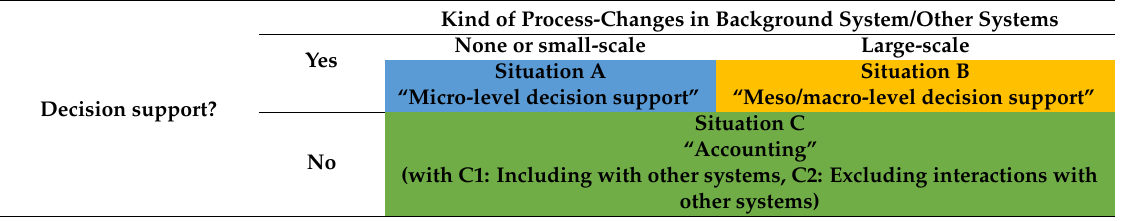
Table 2. Combination of two main aspects of the decision-context: Decision orientation and kind of consequences in background system or other systems [19]. (Reproduced with permission from